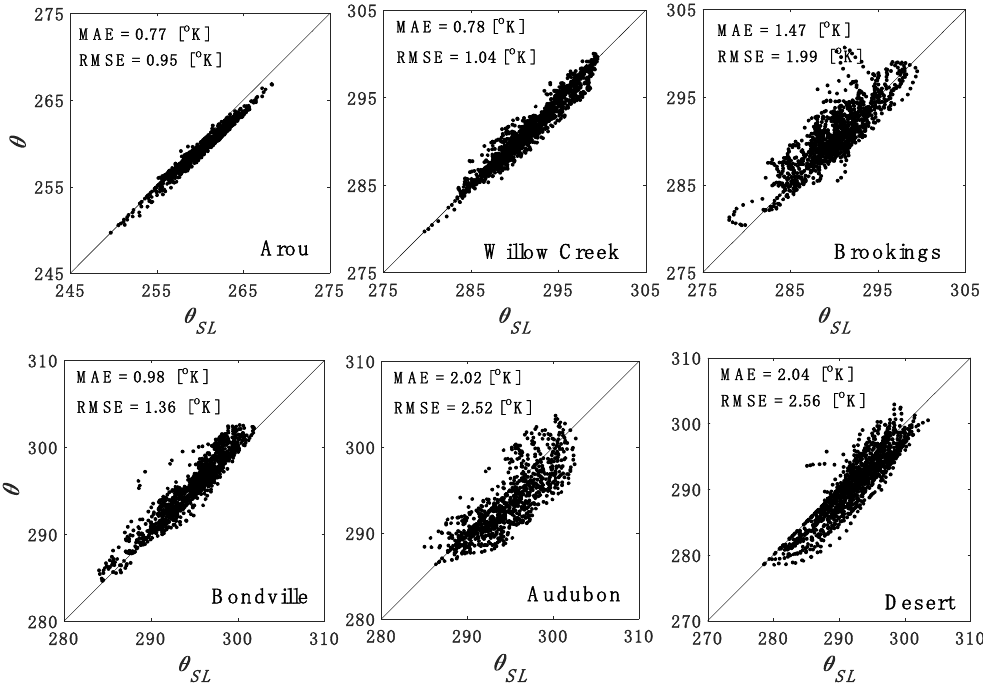
Figure 9. Scatterplot of half-hourly potential temperature ( θ ) estimates from VDA versus θ SL at the six experimental sites.